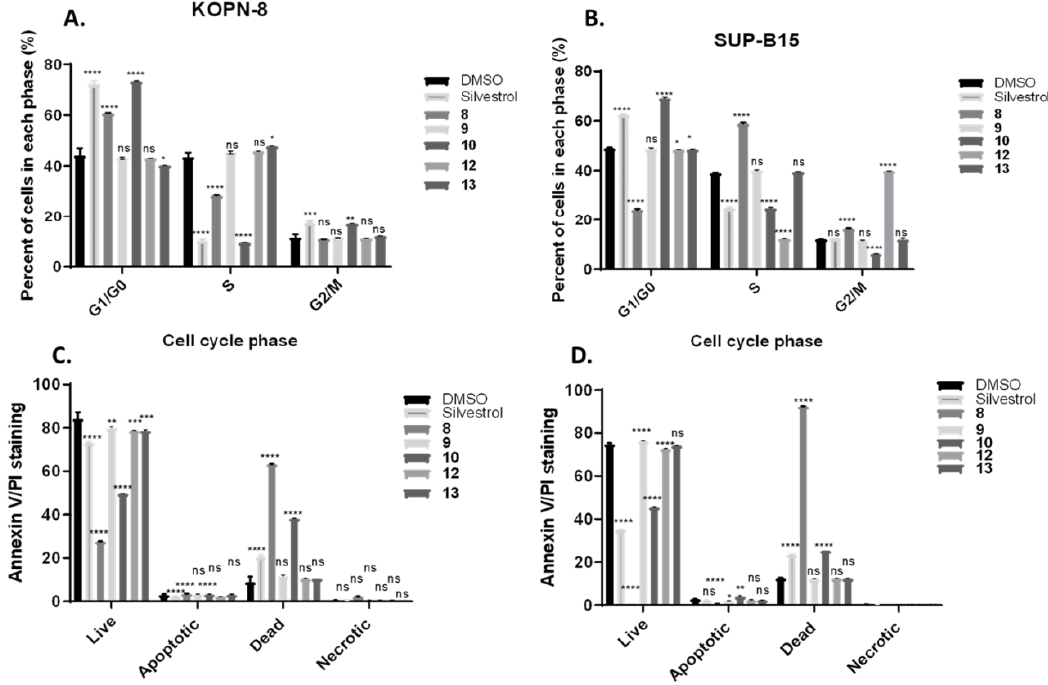
Figure 3. Analysis of apoptosis and cell cycle of compounds 8 – 10 , 12 , and 13 by Annexin V/Propidium Iodide (PI) flow cytometry assay after 24 h treatment using KOPN-8 and SUP-B15 cellular models. Negative control (DMSO), positive control (silvestrol, 5 μ M), compounds 8 (5 μ M), 9 (10 μ M), 10 (5